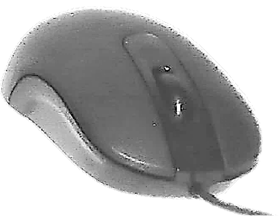
Figure 7. Device used as reference: Microsoft Optical Mouse 200.